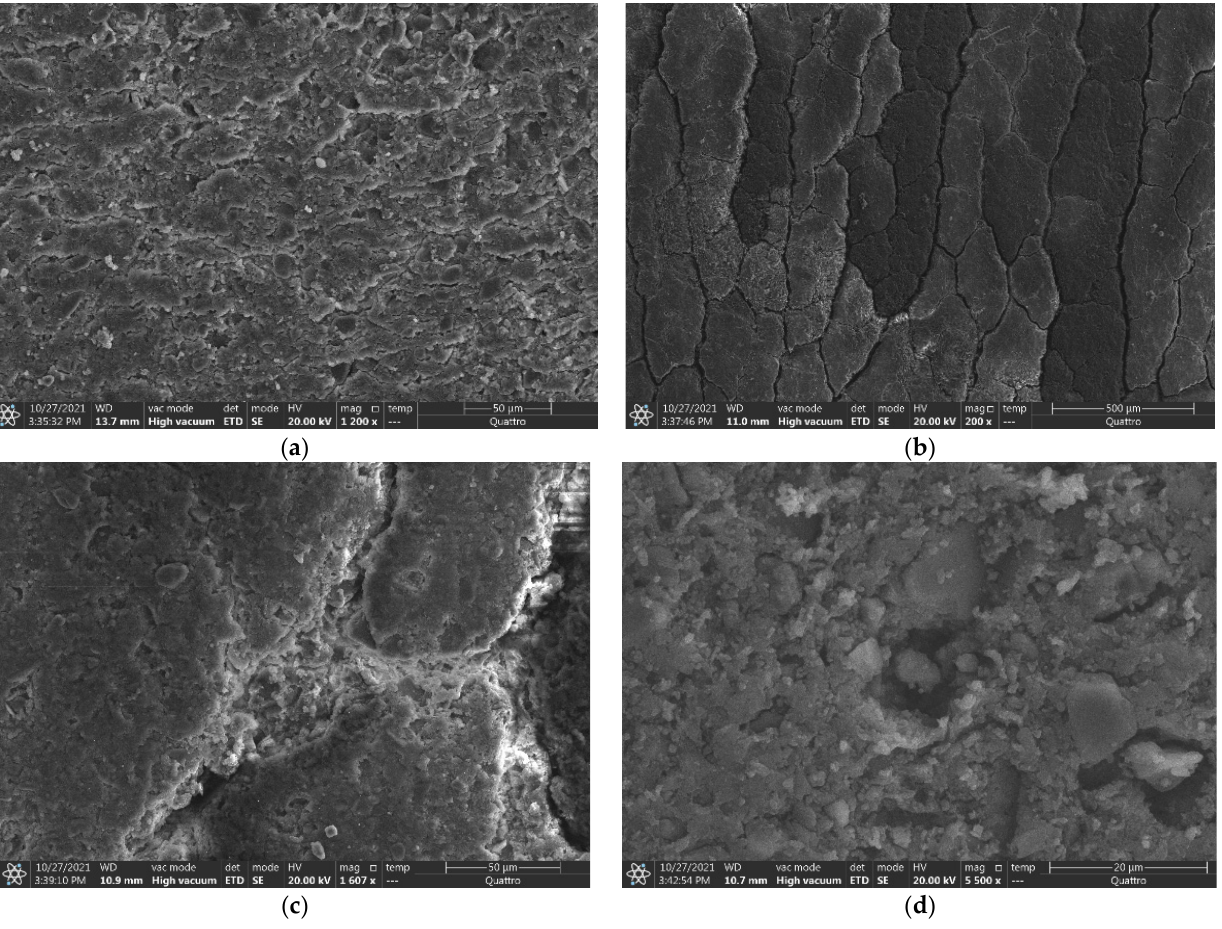
Figure 14. SEM results of 110 kV samples from factory C: ( a ) C ‐ 1, ( b , c ) C ‐ 2, ( d ) C ‐ 3.